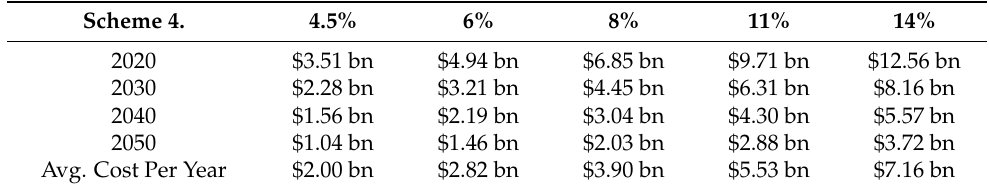
Table 4. Annual implementation costs, including O&M costs, for years 2020, 2030, 2040, and 2050. Scheme 4.